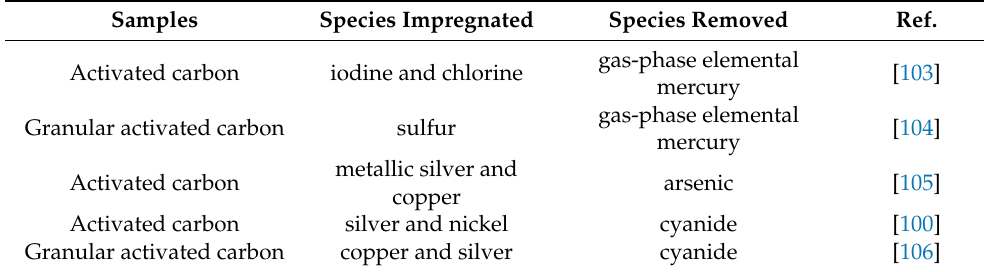
Table 4. Chemically impregnated ACs and their potential